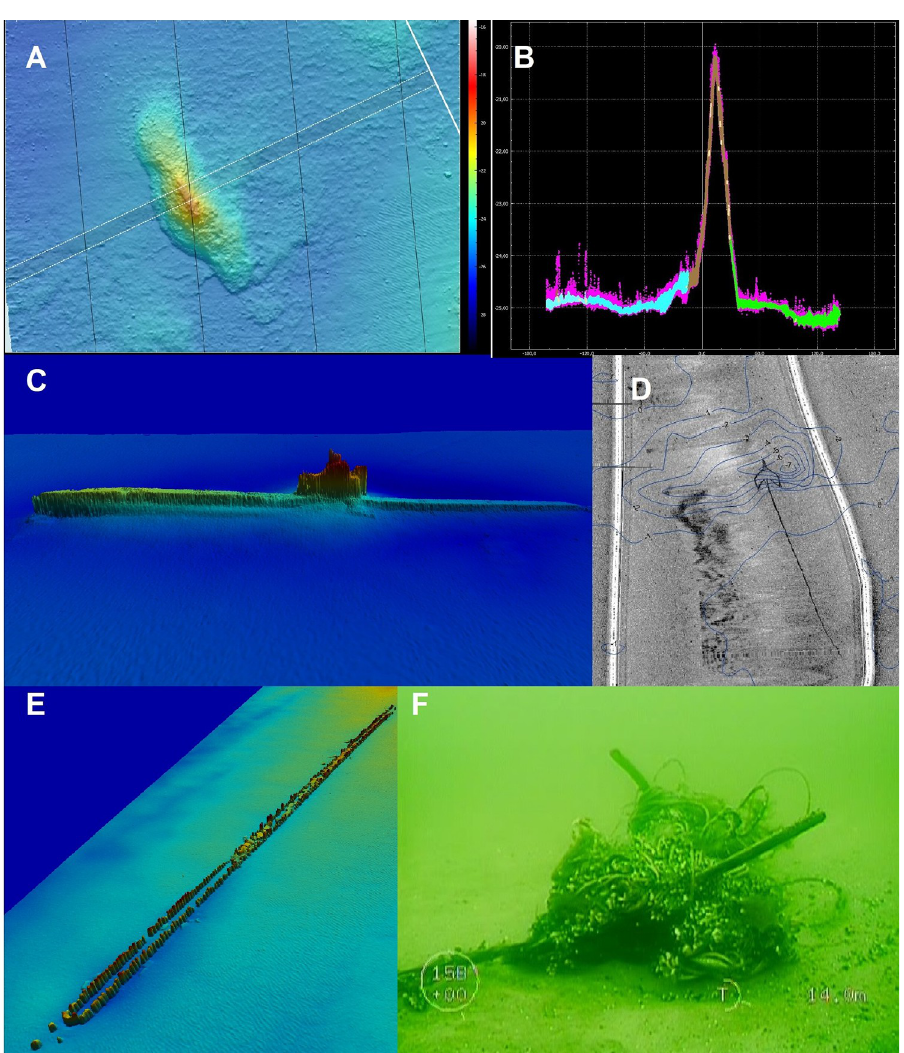
Fig 7. Examples of objects on the seabed which may interfere with the survey: A) geological form on the seabed, image from the multibeam echosounder (MBES), B) single MBES profile in the location of the geological form A—height 5 m above the seabed, C) wreck of the Ś l ą zak vessel, MBES image, D) fishing nets at the seabed of the reservoir, side-scan sonar SSS image with magnetic field anomaly lines, E) Palisade remains, MBES image, F) abandoned fishing nets, ROV TV